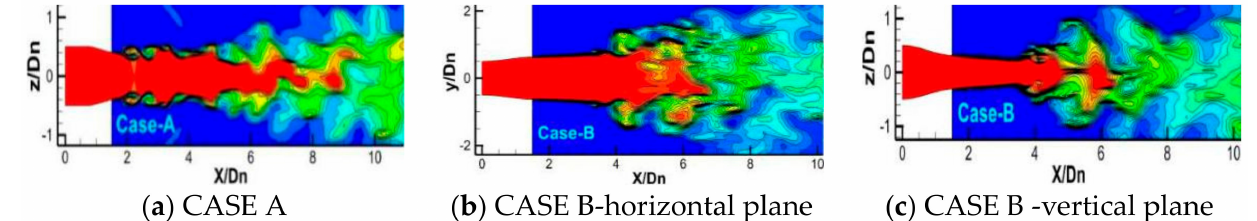
Figure 7. Transient temperature contour on